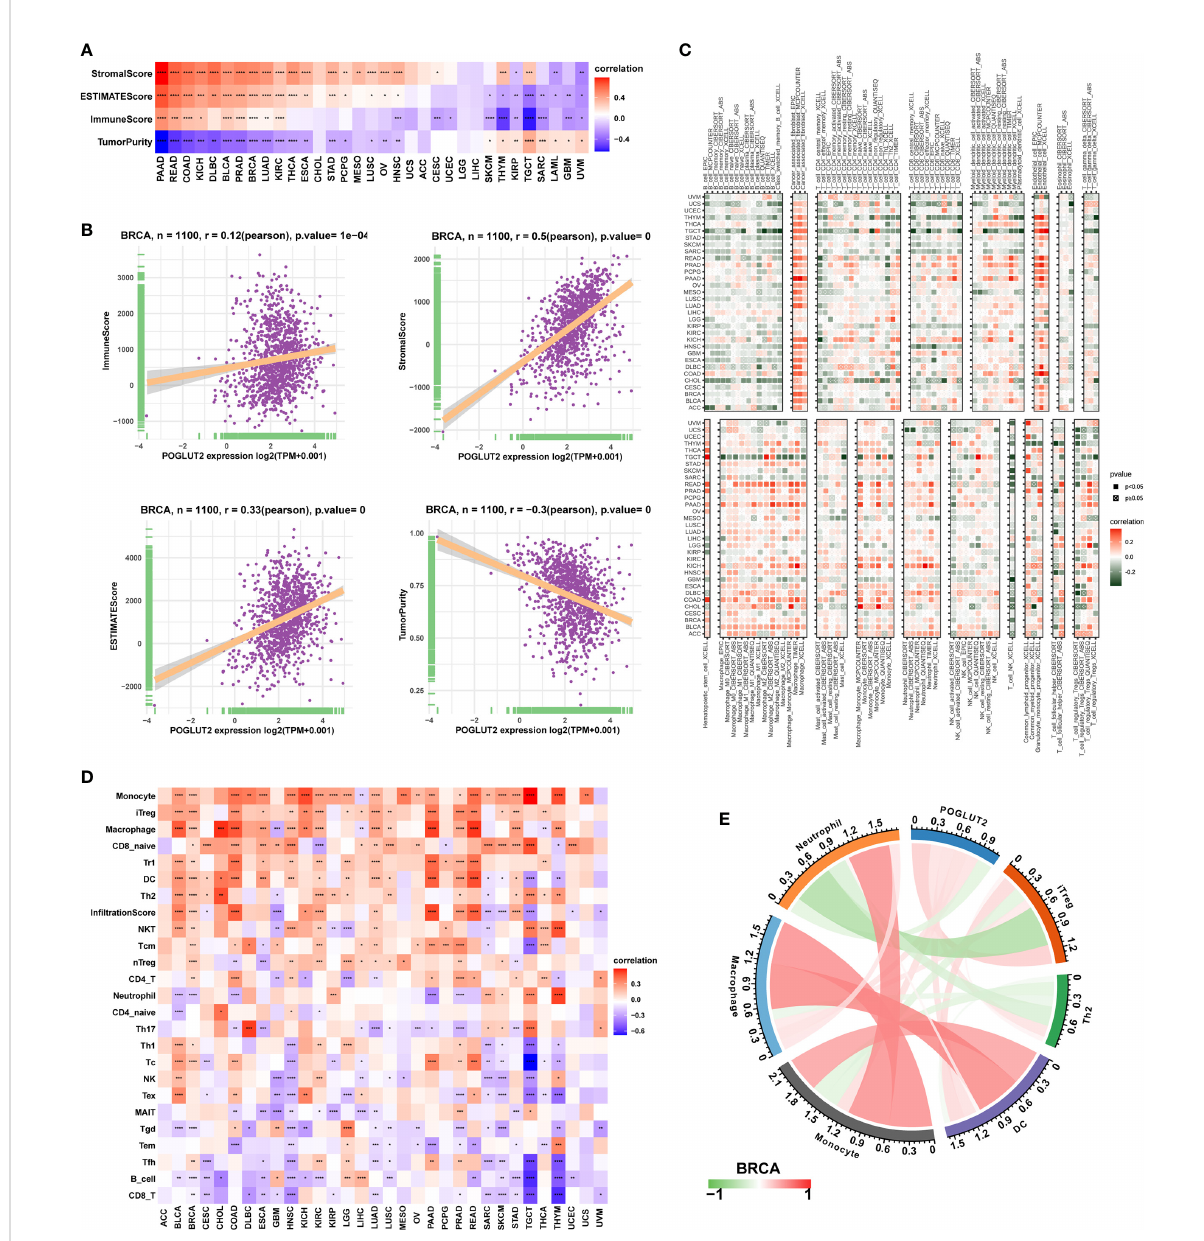
FIGURE 5 The role of POGLUT2 in tumor microenvironment. (A) POGLUT2 correlated Stromal Score, ESTIMATEScore, ImmuneScore, and Tumor purity in different types of cancers. (B) The relationship between POGLUT2 mRNA level and ImmuneScore, Stromal Score, ESTIMATEScore, and Tumor purity in BRCA dataset. (C) The role of POGLUT2 on immune in fi ltration using the data from the TIMER2 database. (D) The role of POGLUT2 on immune cell in fi ltration using data from ImmuCellAI database (http://bioinfo.life.hust.edu.cn/ImmuCellAI#!/). (E) The role of POGLUT2 on immune cell in fi ltration in the setting of breast